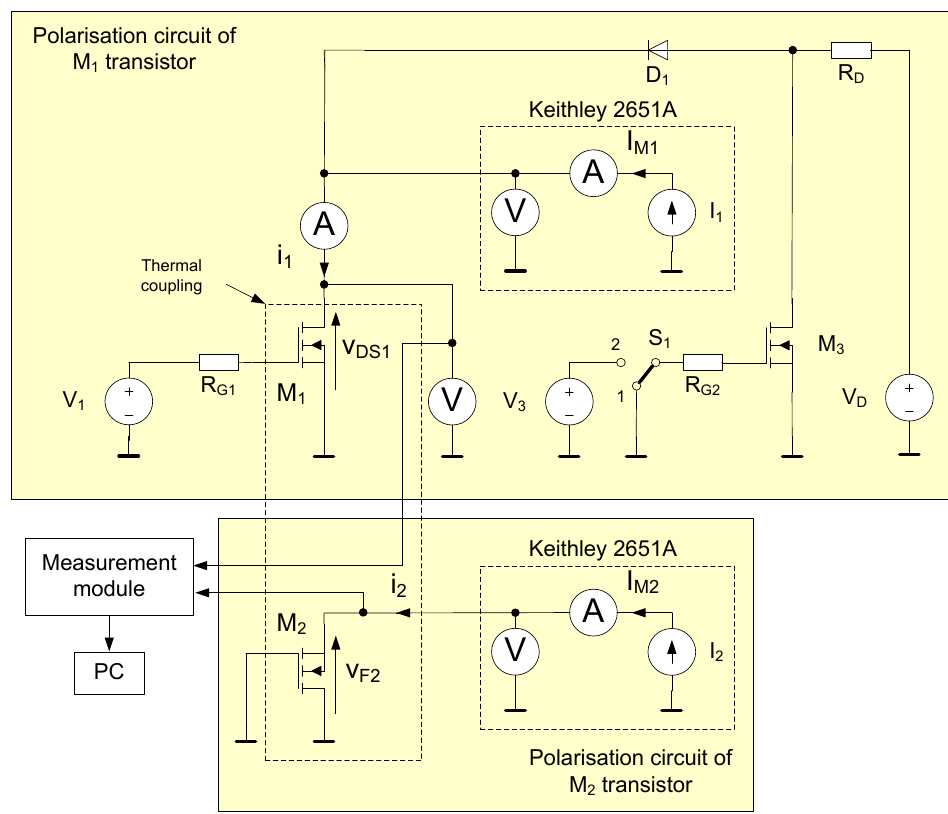
Figure 2. Diagram of the measurement setup for v DS as a TSP for M 1. Both the values of the TSPs and a voltage drop v RTD on both the RTDs were logged with the Measurement Computing USB-2404-60 module [30].